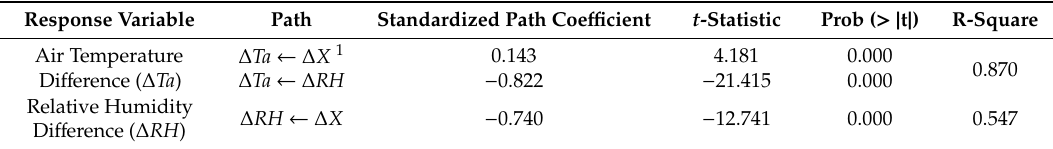
Table 2. Path analysis results of priori model one.